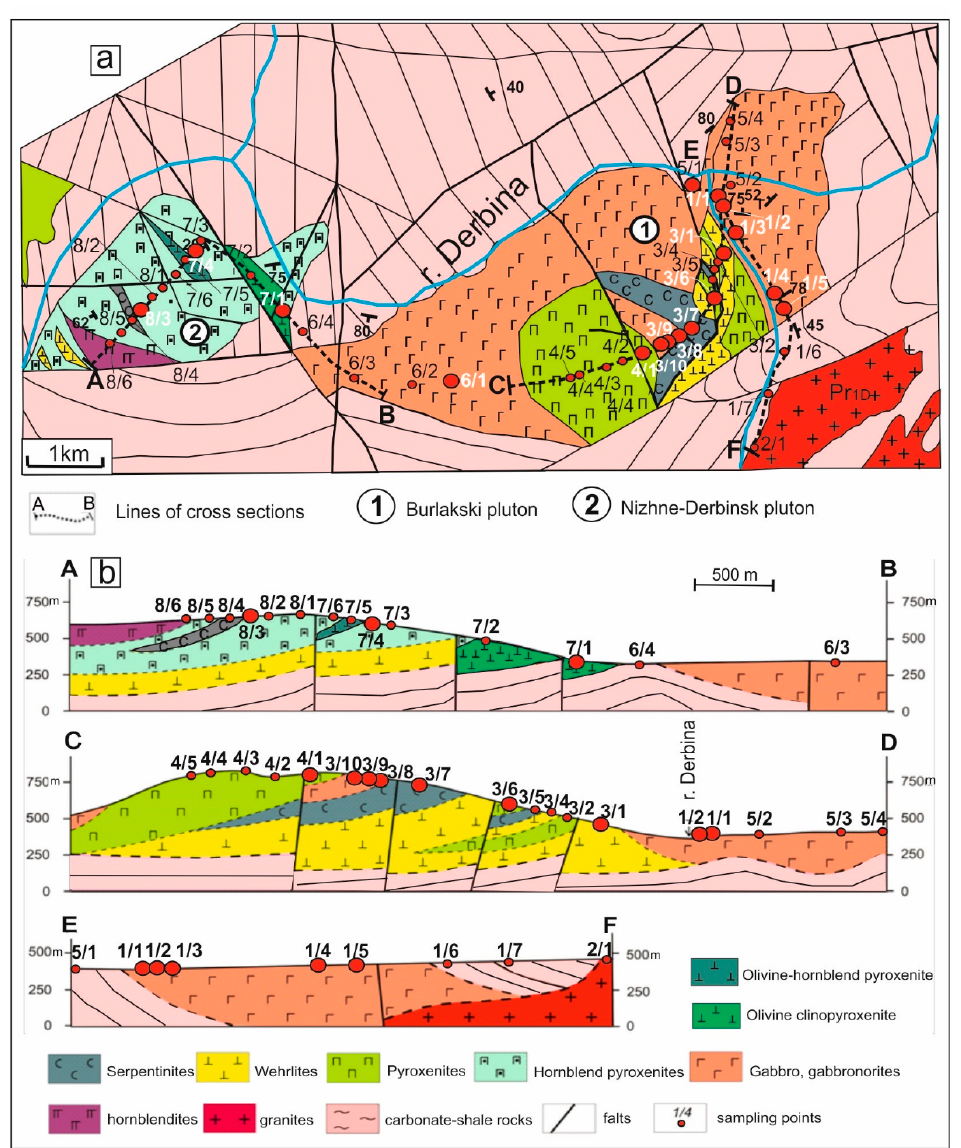
Figure 3. ( a ) Simplified geological map of the Burlakski (1) and Nizhne-Derbinsk (2) mafic-ultramafic plutons. ( b ) Simplified geological cross sections of the Nizhne-Derbinsk ( А –B) and Burlakski (C–D,